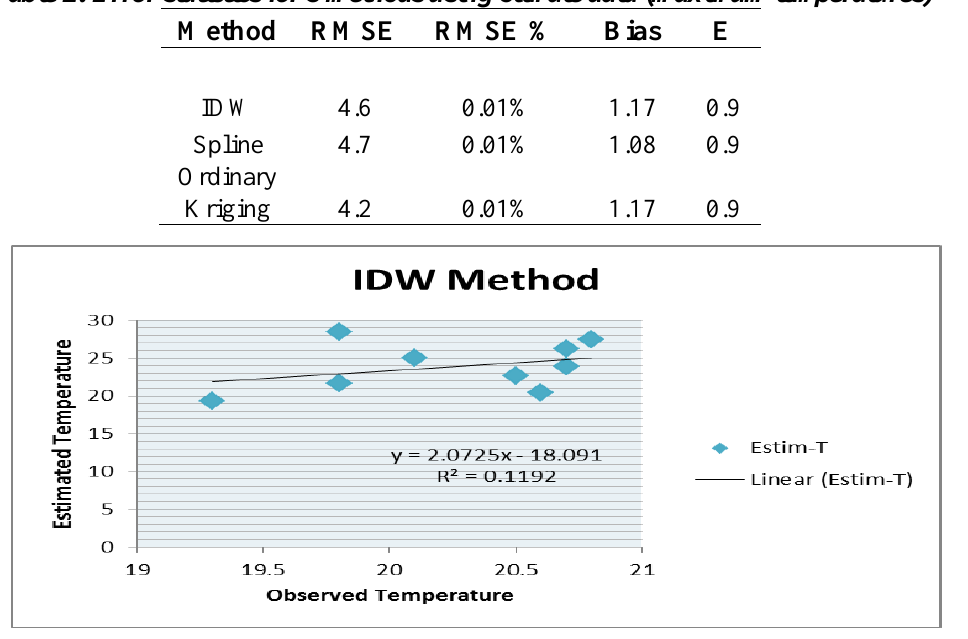
Fig.8: The IDW, comparison of estimated and observed mean Tmax.